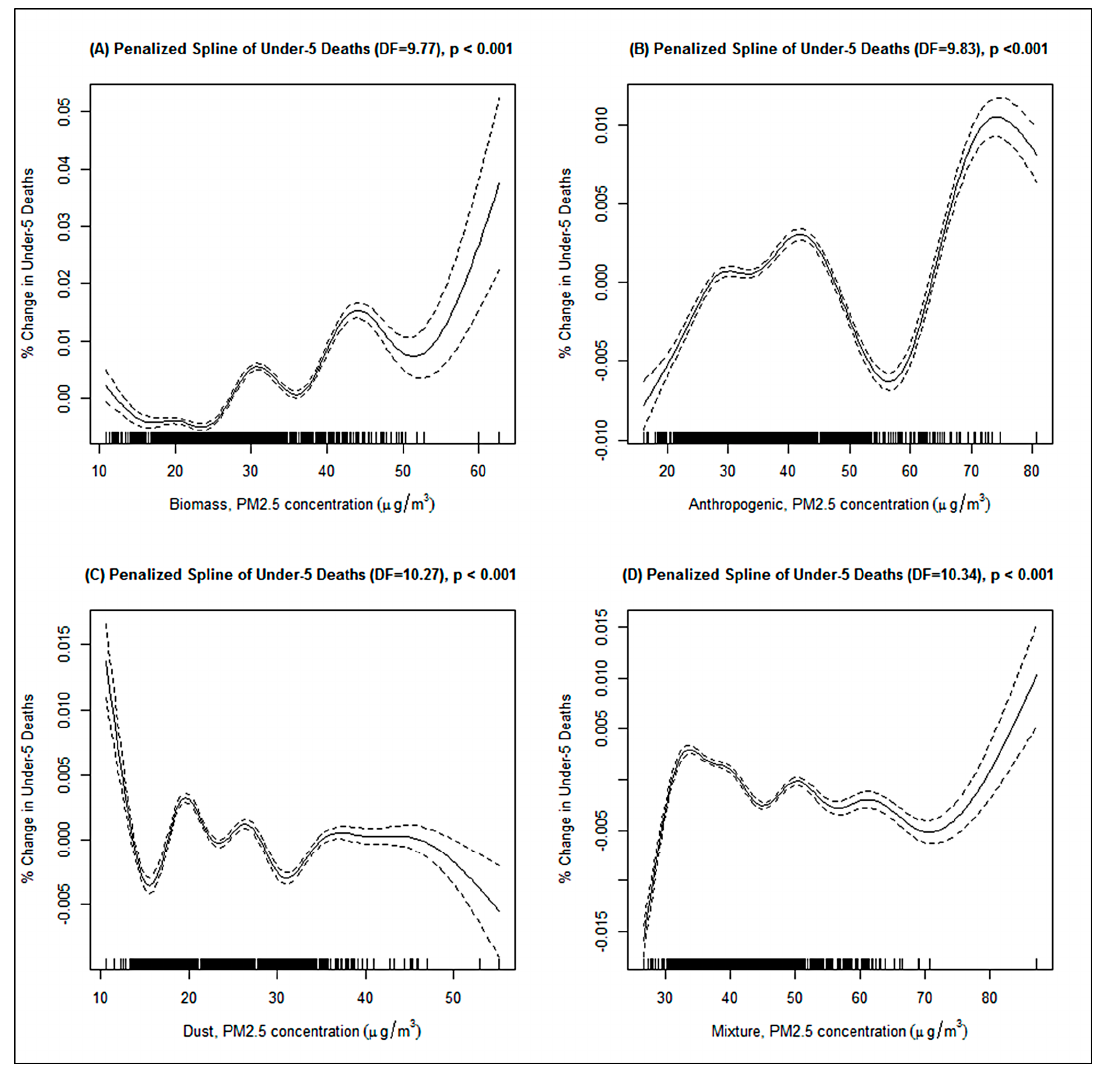
Figure 4. GAMM-estimated relationship between long-term PM 2.5 concentration and under-5 mortality in Africa. ( A ) Biomass PM 2.5 ; ( B ) Anthropogenic PM 2.5 ; ( C ) Dust PM 2.5 ; and ( D ) Mixture PM 2.5 . Adjusted for country, year, total population, urban population, female population, employed population, AIDS death, tuberculosis death rate, undernourished population, and temperature. The continuous line shows the dose-response relationship while the broken line corresponds to 95% confidence interval.